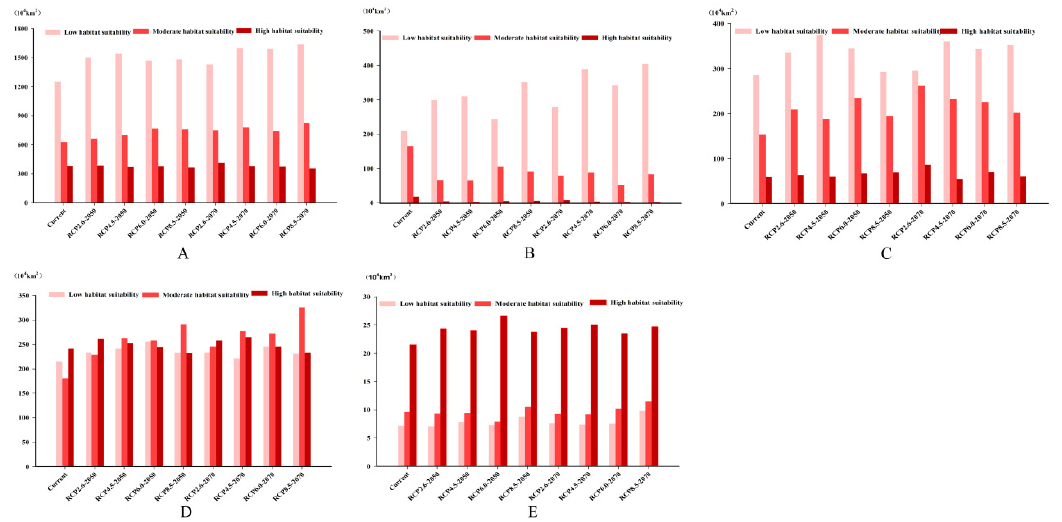
Figure 2. Predicted suitable areas for Pseudaulacaspis pentagona under current and future conditions (km 2 ) ( A ): Globe; ( B ): North America; ( C ): Europe; ( D ): China and Korean Peninsula; ( E ): Japan Pale